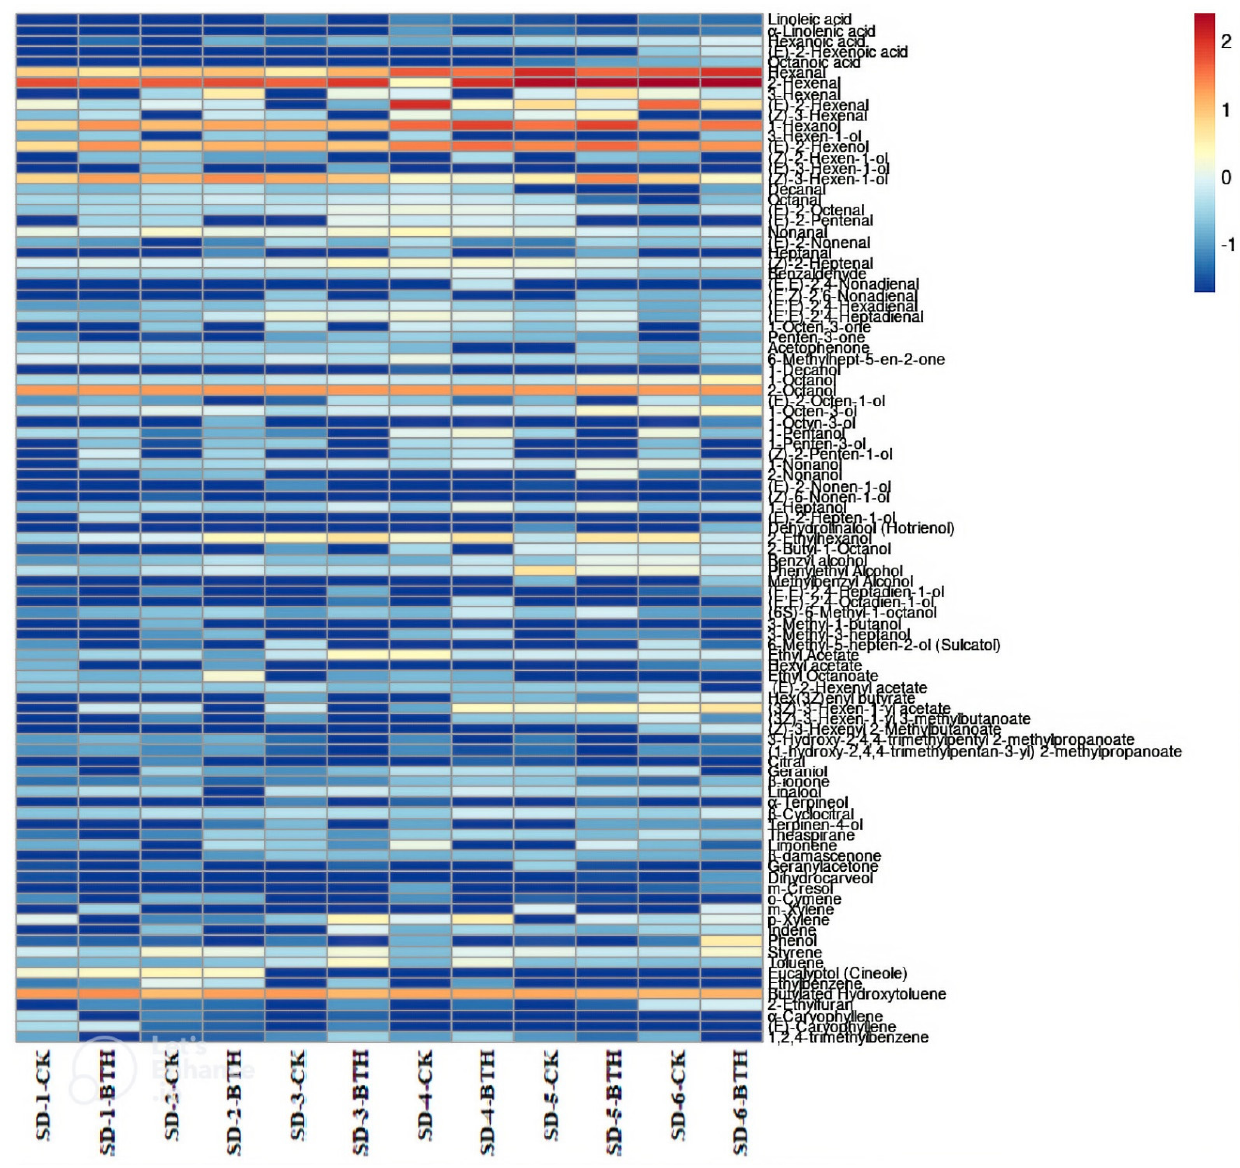
Figure 3. Hierarchical heatmap of volatile compounds in control (CK) and BTH-treated Cabernet Gernischt cv grapes during development. SD; Sampling Date. The color scale shows that com- pounds with high concentrations range from light blue to deep red, while the compounds with low concentrations range from light blue to deep blue.